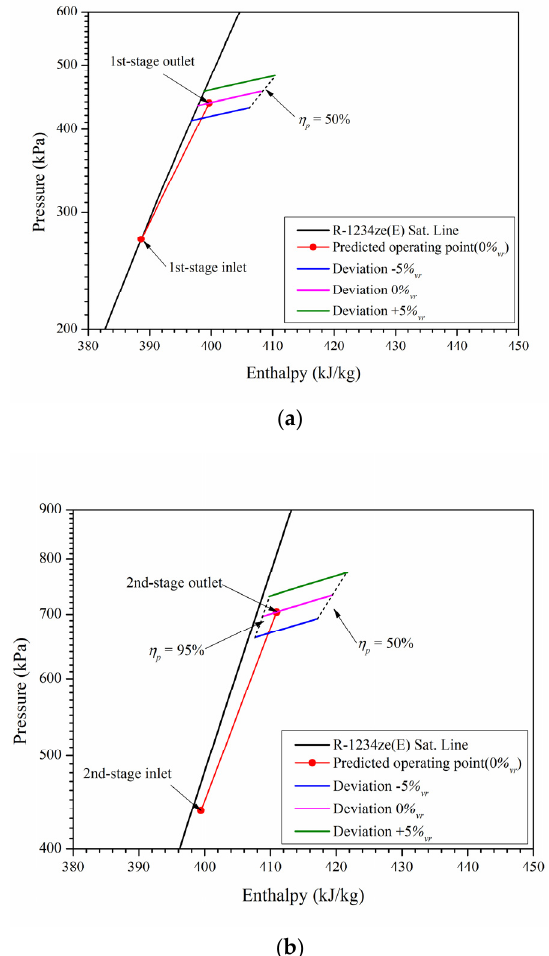
Figure 9. Calculated operating range and operating point for DR-34. ( a ) First stage and ( b ) second stage.